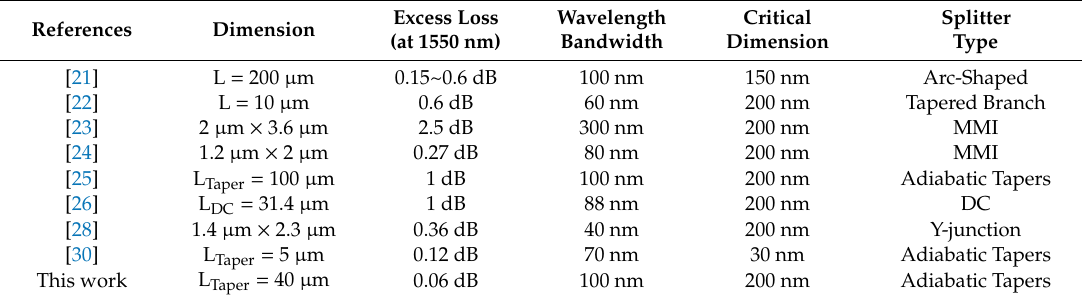
Table 1. Summary of parameters and performances of reported power splitters and this